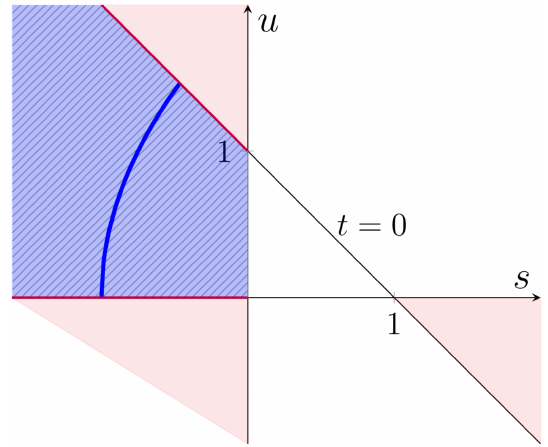
Figure 13: Mandelstam plane for two identical particles (in units of 4 m 2 , t = 1 − s − u ). The three 2 → 2 physical regions (misty rose-coloured online) extend outside the triangle vertices. In the center-left (patterned, purplish online), we show the un- physical region where the integrand in Eq. (93) is evaluated. The arch (thick, blue online) represents the contour of integration for x ∈ [ − 1,1 ] ; the argument of the partial wave on the left cut, s , is negative. Note that along the slanted thick seg- ments (velvet online) the kinematics correspond to the physical u - and t -channels, so the amplitude can be evaluated from data at the end points of the